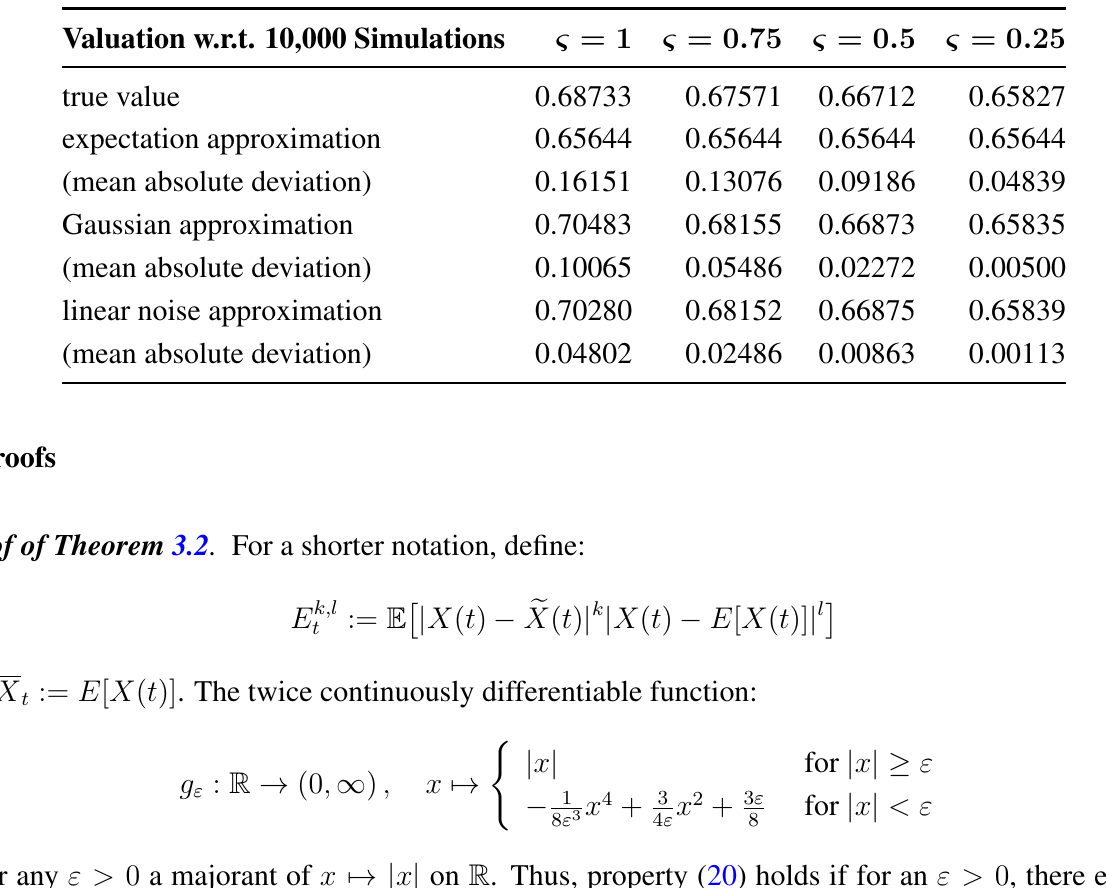
Table 2. Monte Carlo simulation for the expectations of (40) and (41) and for the mean absolute deviation of (41) from